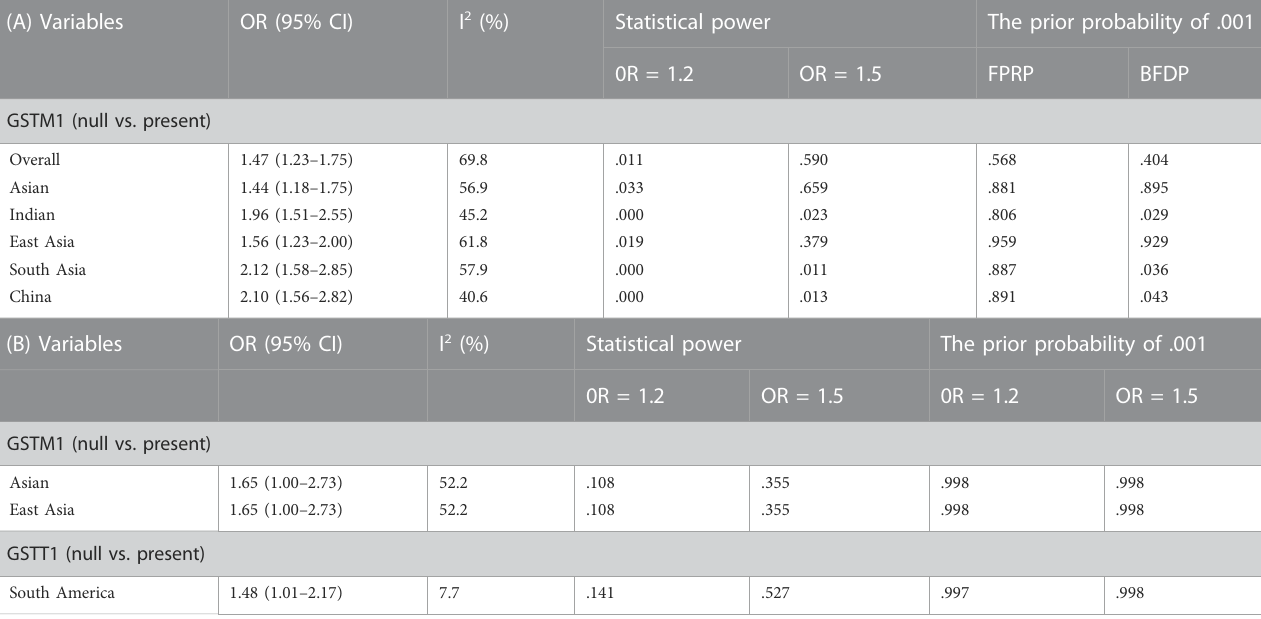
TABLE 10 (A) Cervical cancer false-positive report probability values for the current meta-analysis. (B) Ovarian cancer false-positive report probability values for the current